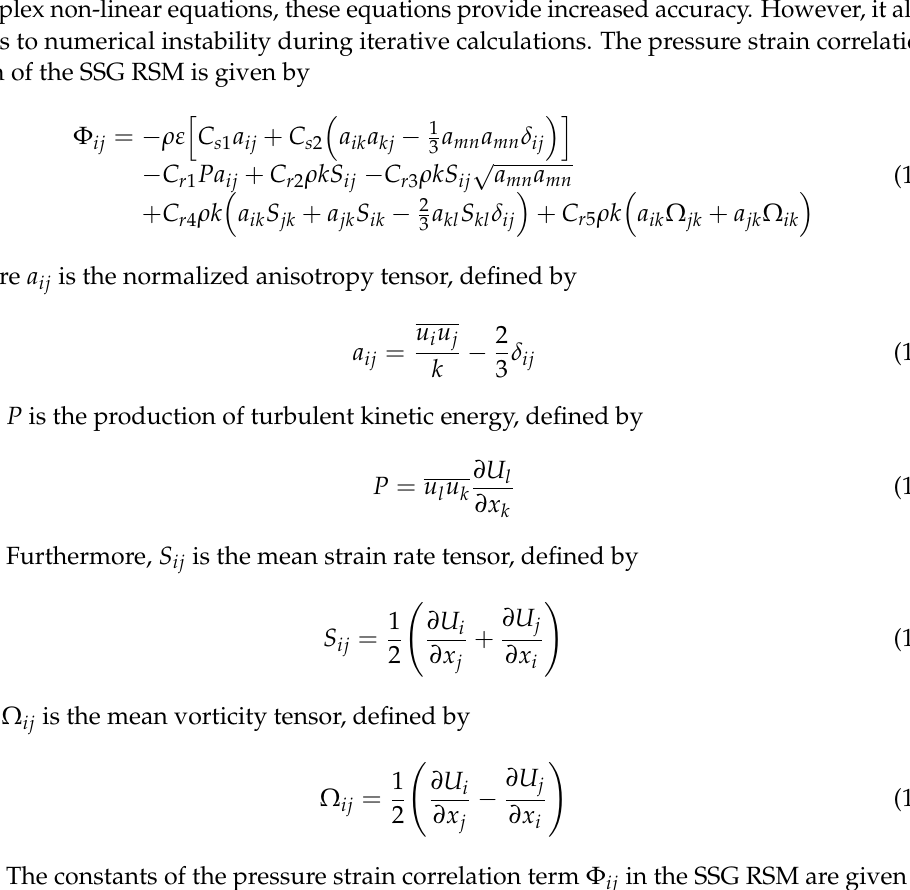
Table 3. The turbulence model equation, SSG RSM, was calculated using the commercial code ANSYS CFX